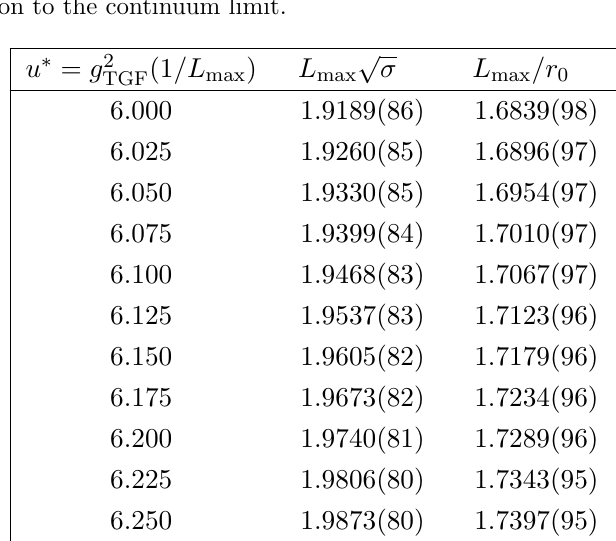
Figure 5 . ( a=L ) 2 dependence of L max the liner extrapolation to the continuum limit.